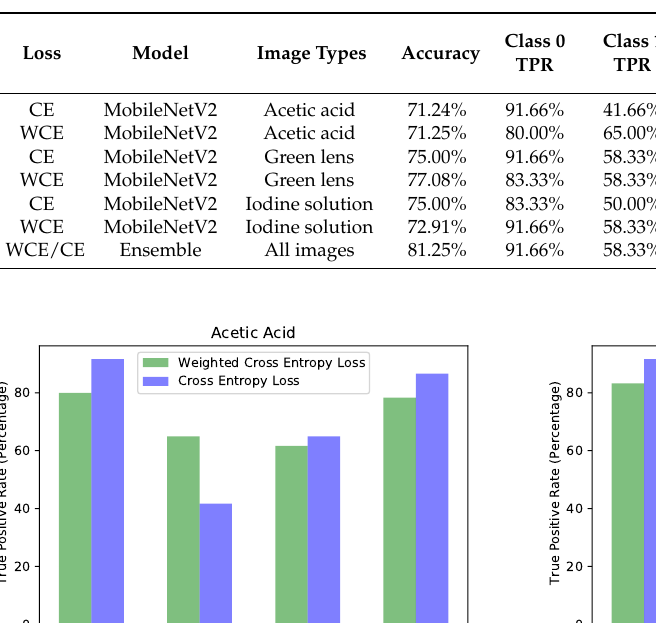
Table 10. Results for training the ensemble and the single networks on the different image types with weighted cross entropy versus simple cross entropy. The transformation applied to the errors is φ ( x ) = exp ( 100 x ) as explained in Section 3.4. The network trained with weighted cross entropy on iodine solution images is not included in the ensemble trained with weighted cross entropy and is replaced with the one trained with cross entropy because it has a better performance. Both ensembles trained with weighted cross entropy and simple cross entropy share the same accuracy and per-class true positive rates. Please note that in this comparison, we did not fine-tune any of the ensembles. In the table, TPR stands for true positive rate, WCE stands for weighted cross entropy, and CE stands for cross entropy.